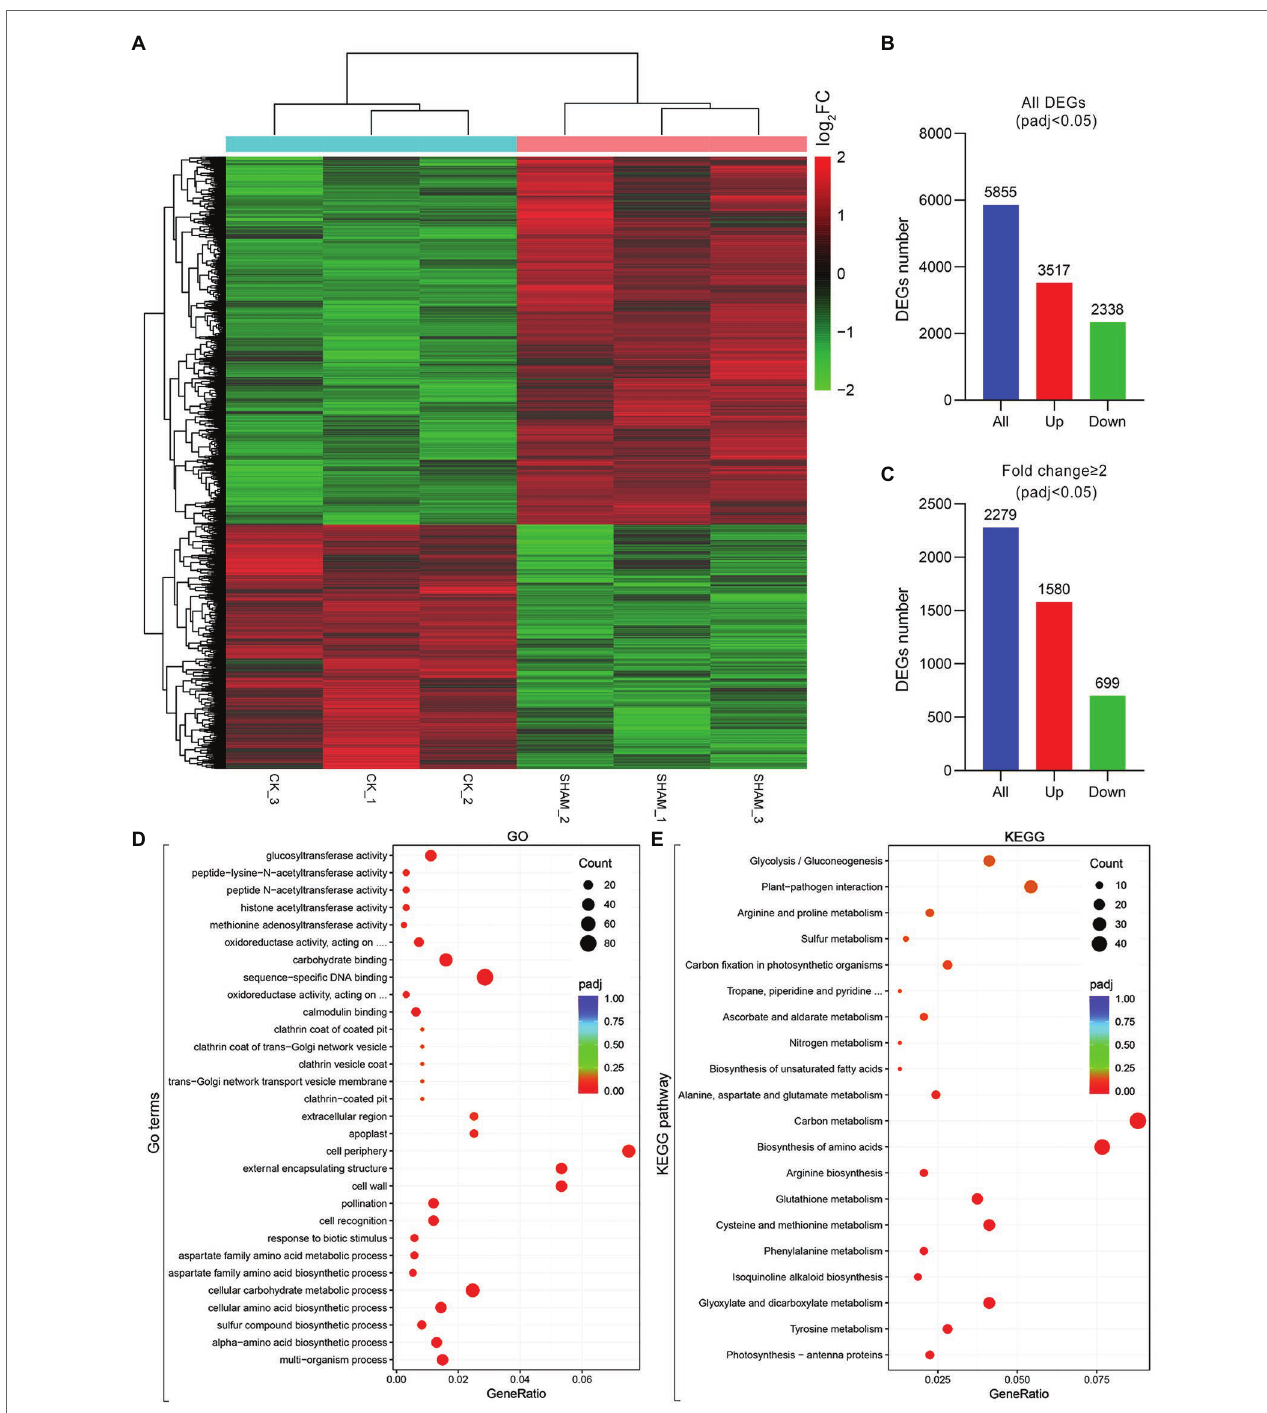
FIGURE 4 | Overview of changes in gene expression profiles of tobacco on SHAM treatment. (A) Heat map diagrams showed the relative expression levels of total differentially expressed genes (DEGs). (B) Number of DEGs includes up- and downregulated genes on SHAM treatment, p adj < 0.05. (C) Number of DEGs (fold change ≥ 2) in SAHM vs. CK. log 2 FC, log 2 FoldChange. (D) Gene Ontology (GO) terms enriched in SHAM vs. CK. (E) KEGG pathway enriched in SHAM vs.